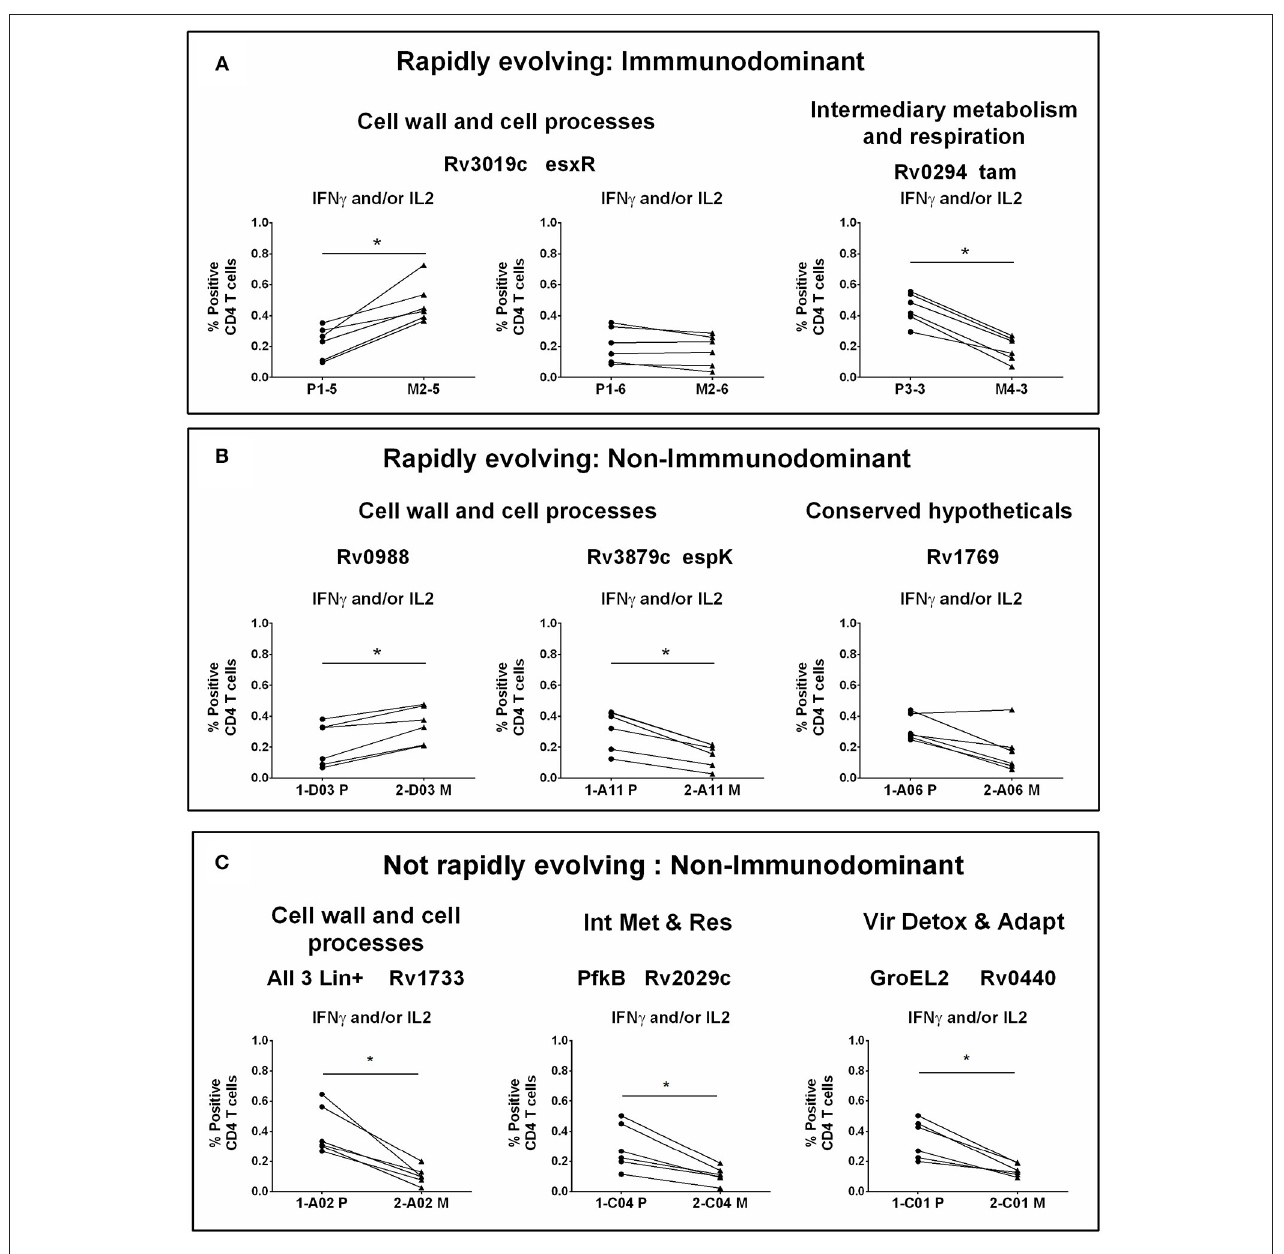
FIGURE 4 | CD4T cell responses to parent and mutant peptides. PBMCs from IGRA + subjects were stimulated overnight with parent and mutant peptides that are either rapidly evolving or not-rapidly evolving and belonging to immunodominant and non-immunodominant category. Frequencies of IFN γ + and/or IL2 + CD4T cells were determined by ICS assay (see methods). Line graphs shows IFN γ and/or IL2 CD4T cell frequency following stimulation with a set of nine parent and mutant peptides as individual plots in IGRA + subjects after subtraction of background unstimulated control. Each line is a donor. Statistical analysis was performed using nonparametric Wilcoxon matched-pairs signed rank test. * P < 0.05 was considered significant. mTCE were grouped as follows: (A) Rapidly evolving and immunodominant Rv3019c (EsxR) and Rv0294 (tam). (B) Rapidly evolving and non-immunodominant Rv0988, Rv3879c (espK) and Rv1769. (C) Not rapidly evolving and non-immunodominant Rv1733, Rv2029c, and Rv0440.